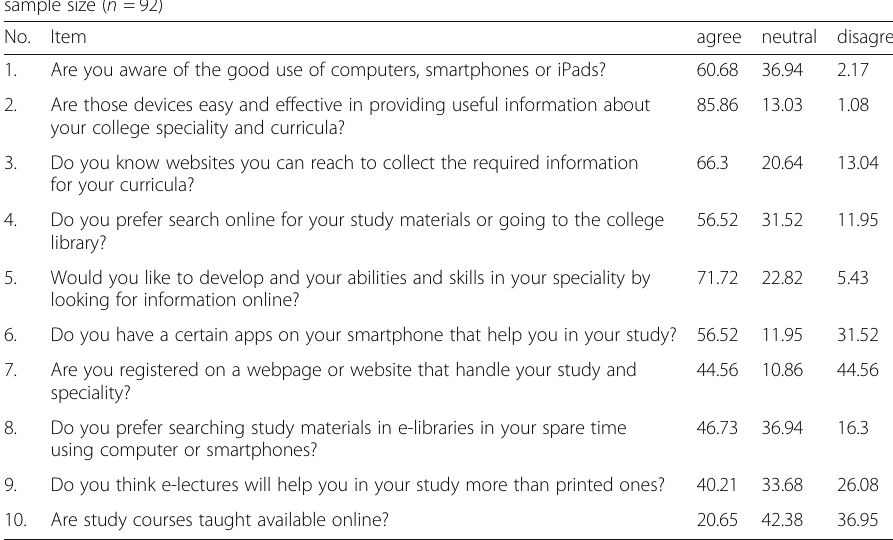
Table 1 Sample answers on the closed questions